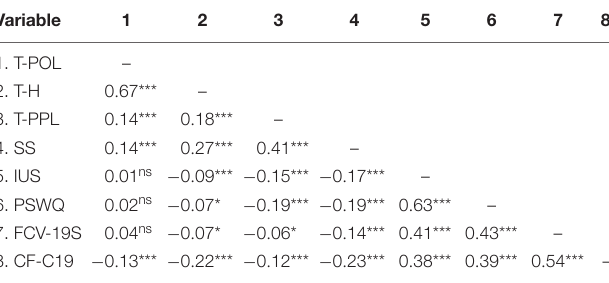
TABLE 2 | Correlations between the variables used in the study.